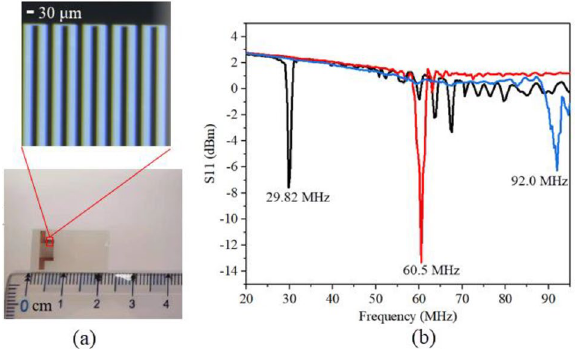
Figure 2. The device characterization ( a ) Image of the SAW substrate showing an enlargement of the IDTs for a 30 MHz SAW device. ( b ) Frequency response curves of SAW devices at different